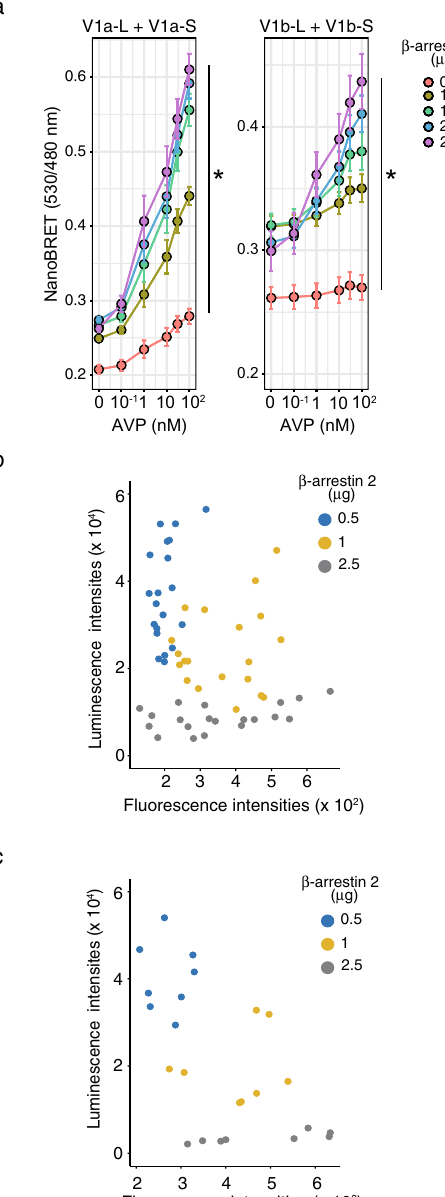
Figure 6. Increasing the expression level of β-arrestin 2-Venus increased the NanoBRET signals in cells expressing the homodimeric V1a or V1b receptor. ( a ) Indicated amounts of the β-arrestin 2-Venus plasmids were cotransfected with V1a-LgBit plus V1a-SmBit or V1b-LgBit plus V1b-SmBit. NanoBRET signals were examined after AVP stimulation at the indicated concentrations. (n = 8 and 6 for the V1a and V1b dimers, respectively) *indicates that the β-arrestin 2-Venus plasmid amounts were significant determinants for the BRET responses ( p < 0.05). ( b,c ) A fixed amount (0.05 μg) of V1a-LgBit plus V1a-SmBit ( b ) or V1b-LgBit plus V1b-SmBit ( c ) was cotransfected with the indicated amount of β-arrestin 2-Venus. The luminescence and fluorescence intensity ratios were examined from 36 to 48 h after transfection. (n = 20 and 8 for the V1a and V1b dimers, respectively) The statistical computer program R version 4.0.3 (R Core Team, [2020], Vienna, Austria. https:// www.r- proje ct. org) was used to prepare Fig.